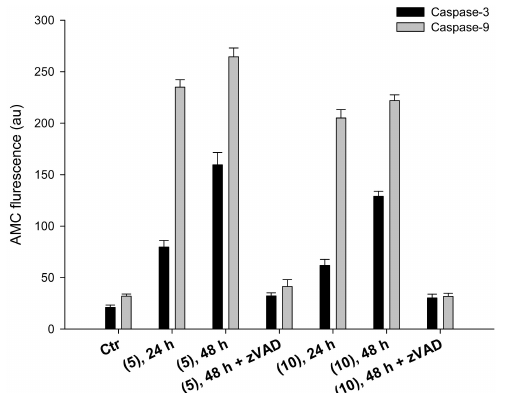
Figure 8. Caspase-3 and -9 activation. E ff ect of silver(I) compounds on caspase-3 and -9 activation. 2008 cells were incubated for 24 or 48 h with IC 50 of compounds ( 5 ) or ( 10 ), broad-spectrum caspase inhibitor zVAD, and processed for caspase-3 and -9 activity. Data are the means of at least three independent experiments. Error bars indicate